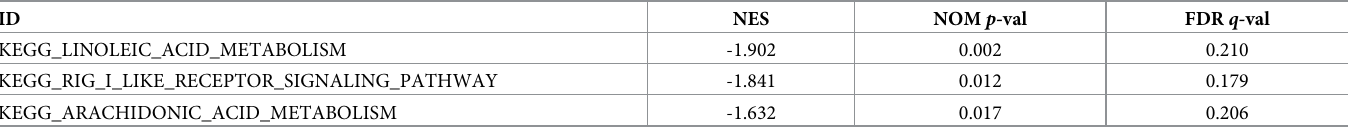
Table 8. Gene sets enriched in the low-risk phenotype via